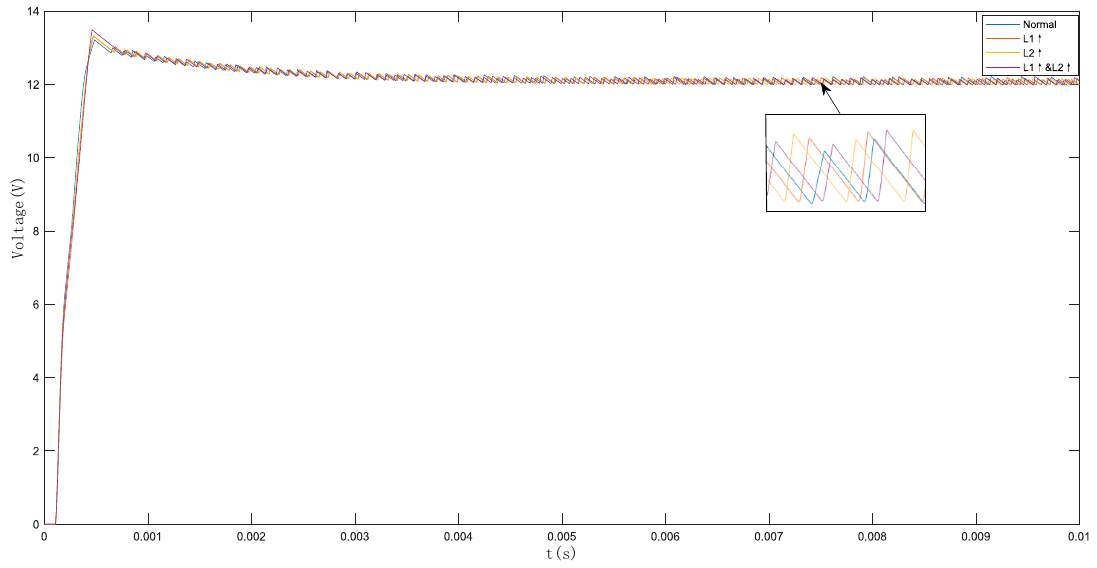
Figure 2. Output response of the Superbuck converter with recessive weakness.